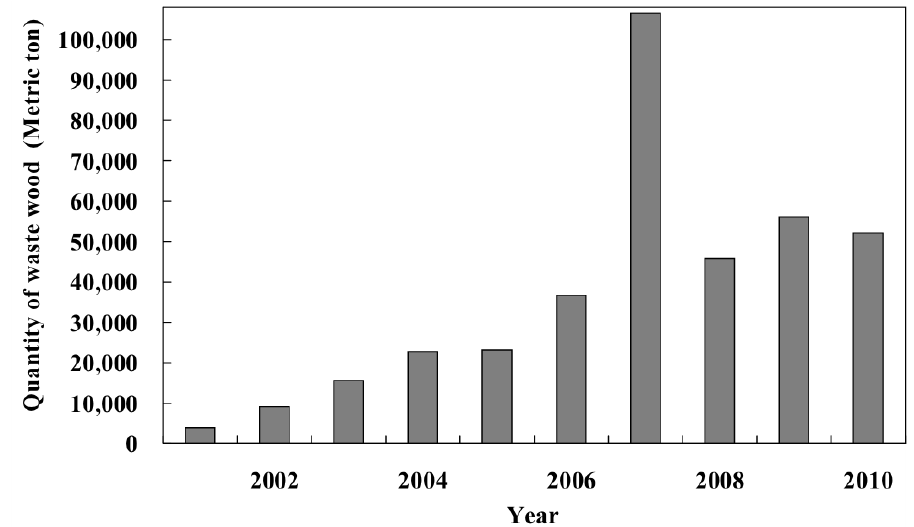
Figure 1. On-line reported quantities of reused waste wood generated from the industrial sector of